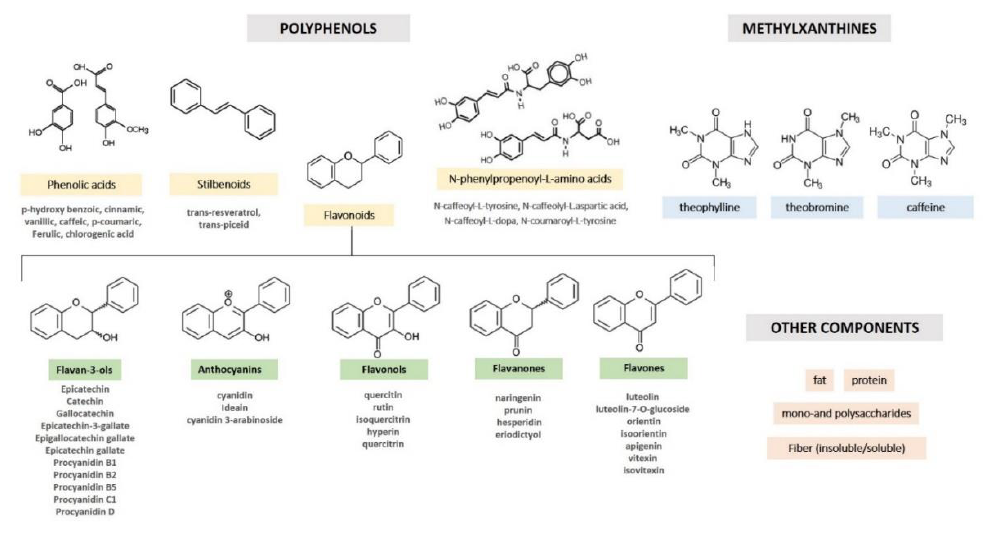
Figure 1. Nomenclature and chemical structures of cocoa phytocomplex.